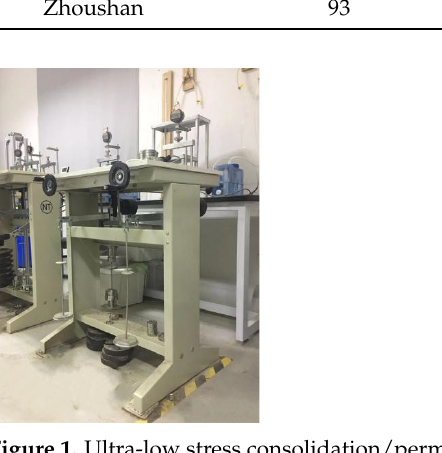
Figure 1. Ultra-low stress consolidation/permeability tester. Table 2. Proportion scheme in the test.